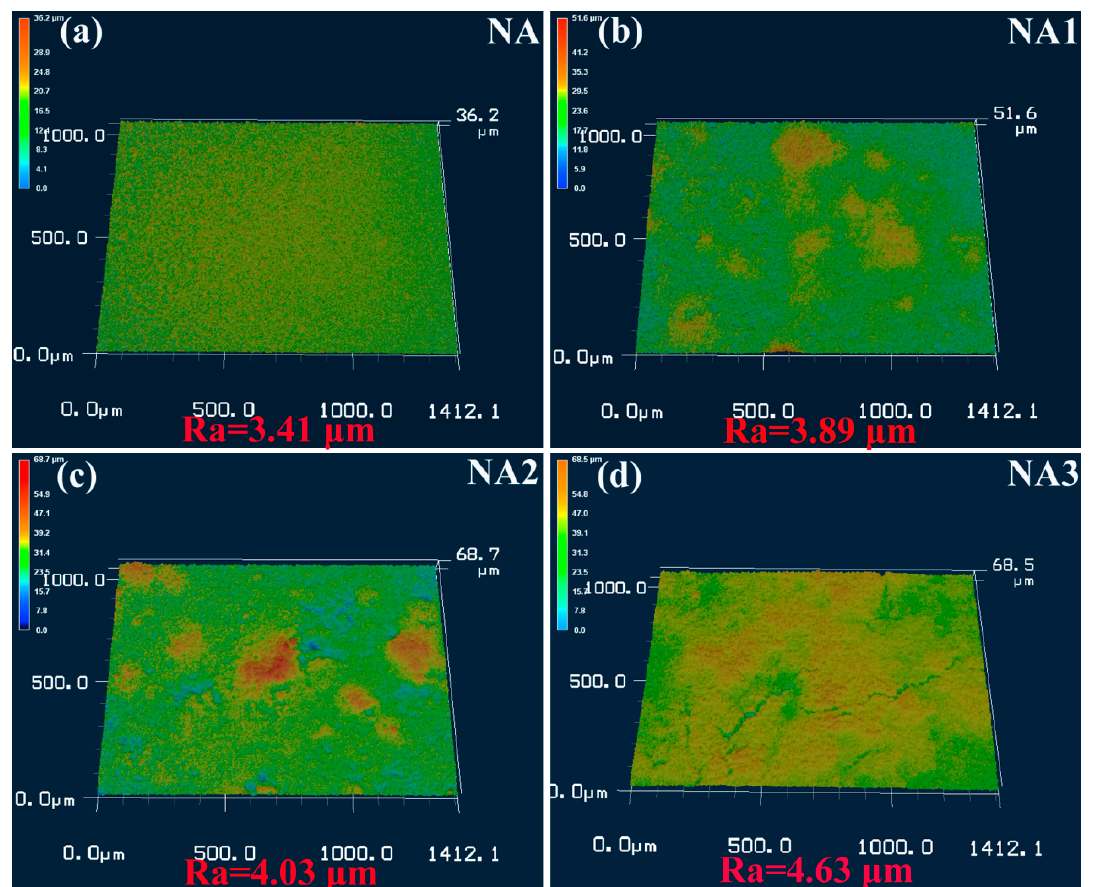
Figure 8. 3D laser scanning confocal microscope topography of the composites after oxidation for 100 h at 800 °C: ( a ) NA; ( b ) NA1; ( c ) NA2; ( d ) NA3.